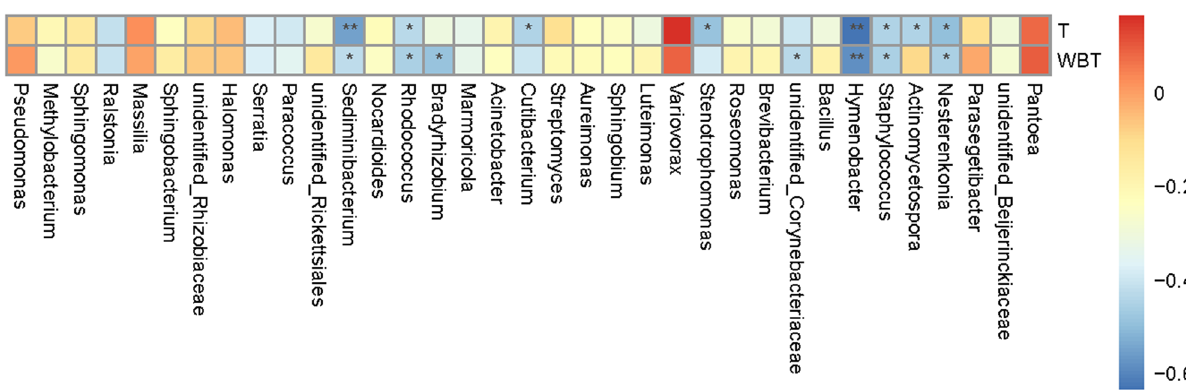
Figure 11. Heat map of correlation with environmental factors at the level of